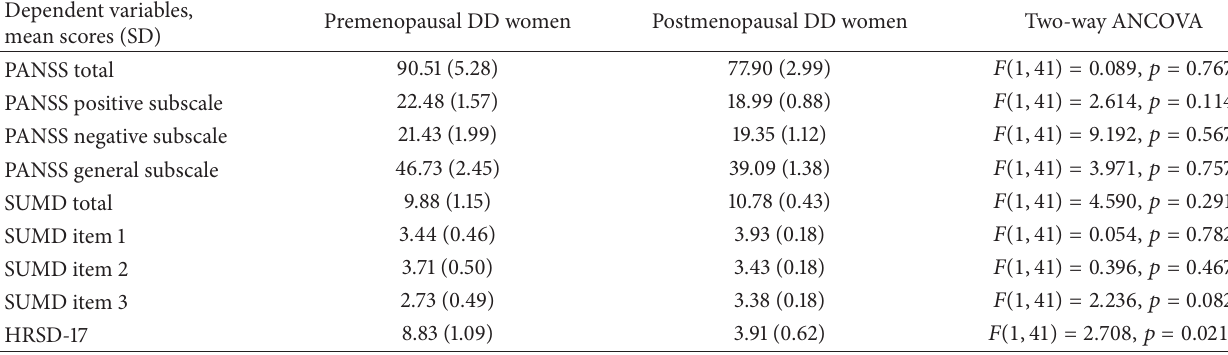
Table 2: Psychopathological scores after 24 months adjusted for covariates and multivariate comparisons by groups.